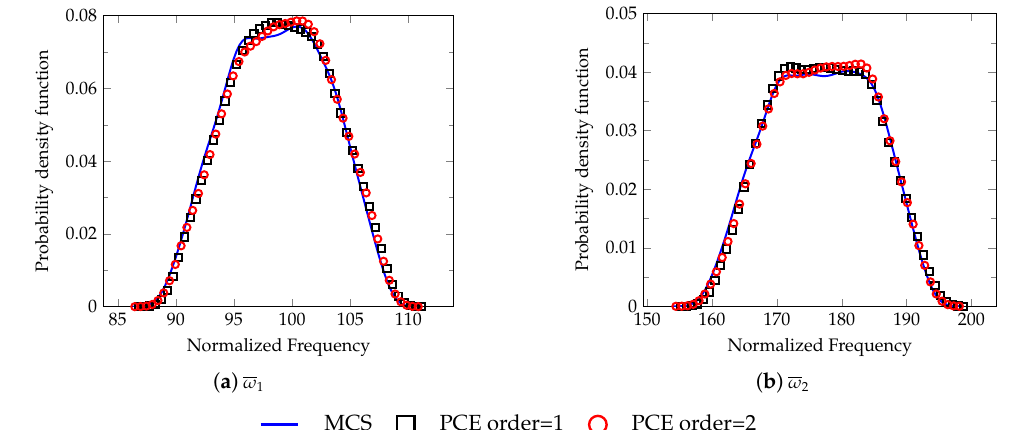
Figure 7. Case C: Variation of the probability density function as a function of normalized frequency, for the first two normalised frequencies; considering gradient index, n = 5 and the Young’s modulus of both metal and ceramic as random.